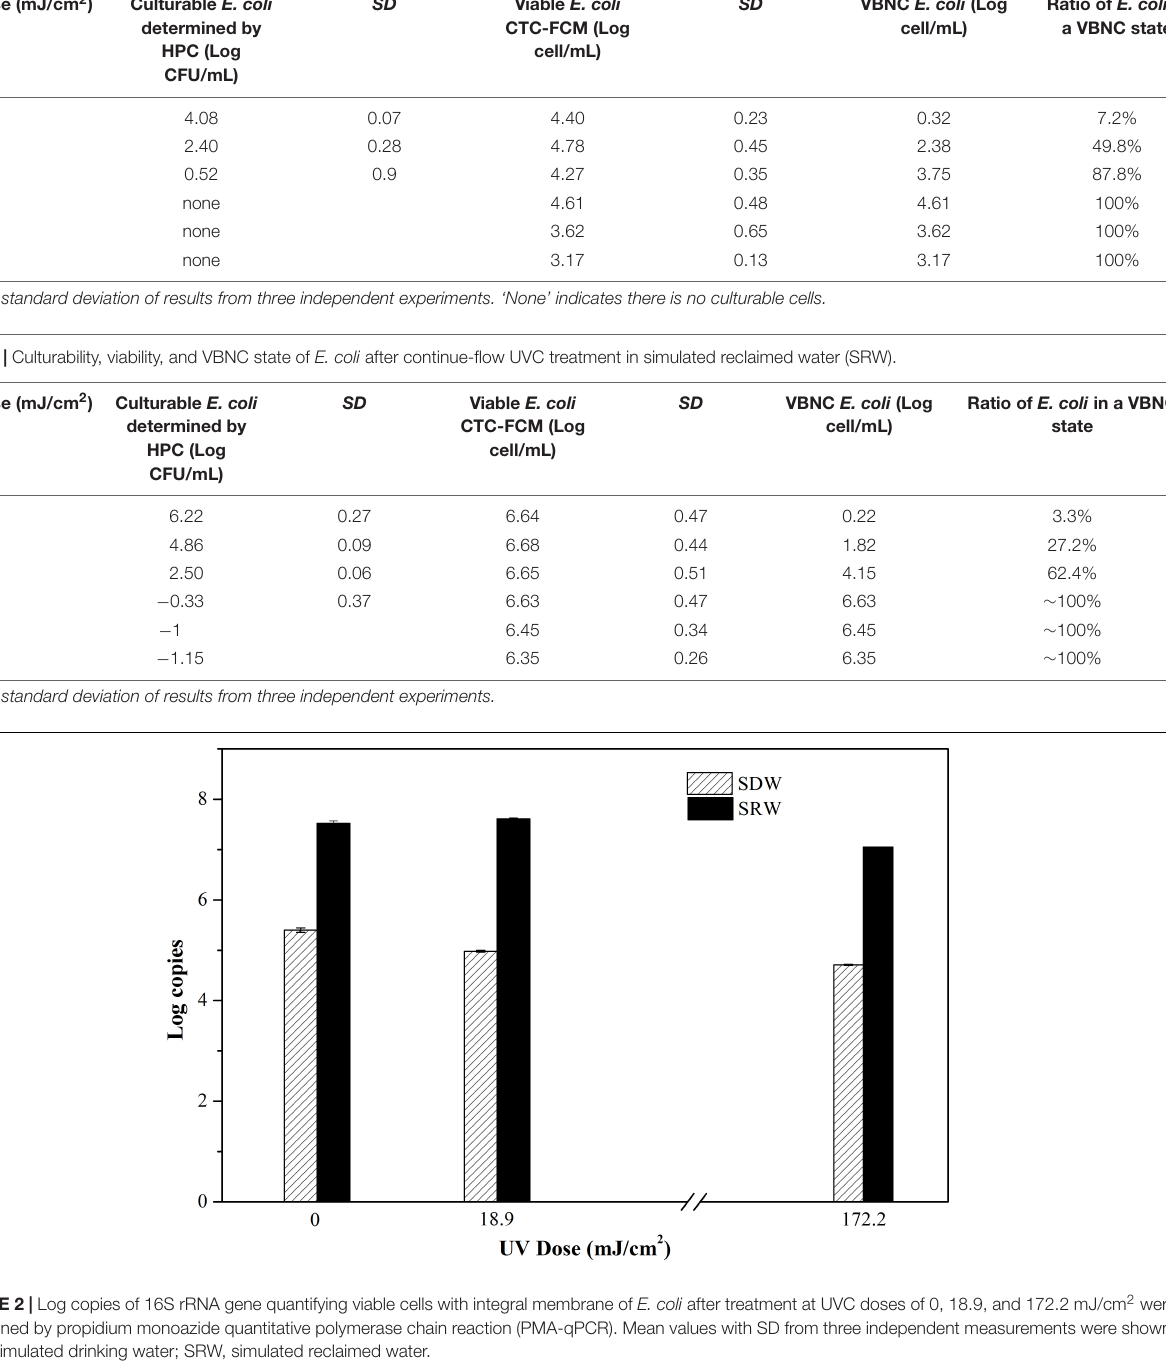
TABLE 1 | Culturability, viability, and VBNC state of E. coli after continue-flow UVC treatment in simulated drinking water (SDW). UVC dose (mJ/cm 2 )